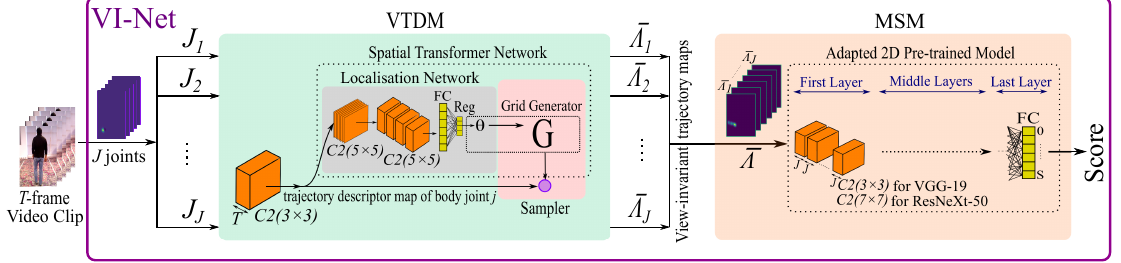
Figure 1. VI-Net has an view-invariant trajectory descriptor module (VTDM) and a movement score module (MSM) where the classifier output corresponds to a quality